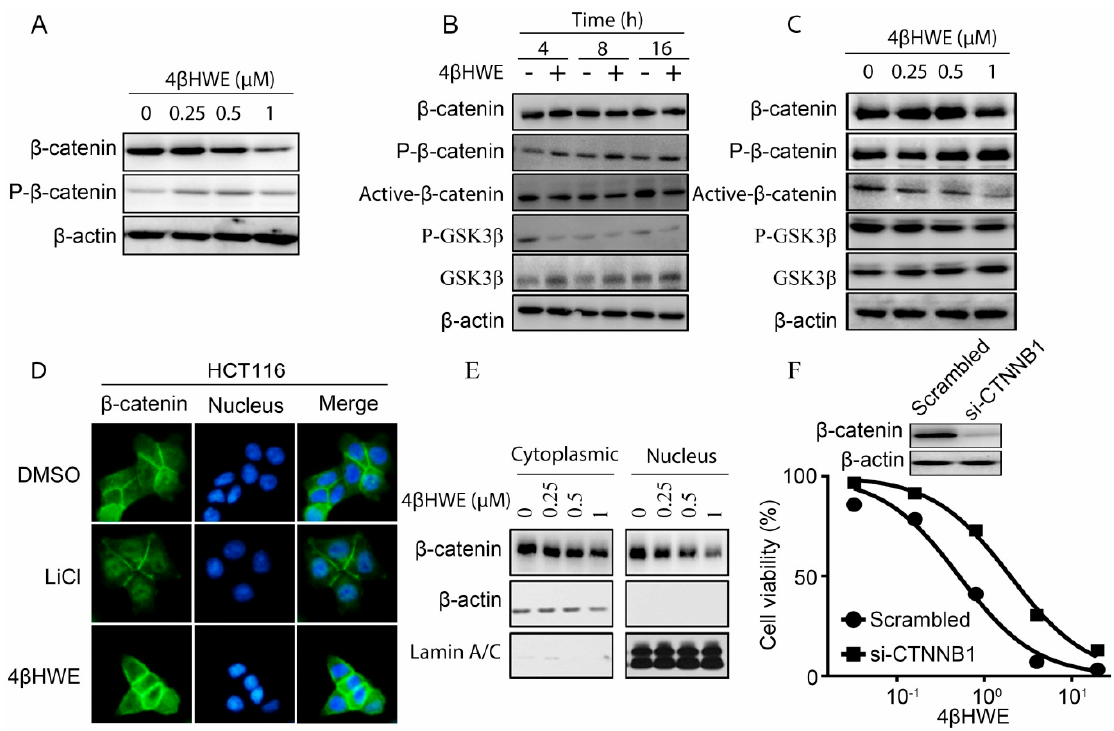
Figure 3. 4 β HWE disrupts the stability and nuclear translocation of β -catenin in colorectal cancer cells. ( A ) HEK293 cells stably transfected with Wnt3a were treated with 4 β HWE for 24 h; β -catenin and p- β -catenin (Ser33, Ser37, and Thr41) were detected with western blot analysis. ( B ) HCT116 cells were treated with 1 μ M of 4 β HWE for 4 h, 8 h, and 16 h or indicated concentrations of 4 β HWE for 16 h respectively ( C ), and western blot analysis of β -catenin, p- β -catenin (Ser33, Ser37, and Thr41), active- β -catenin, p-GSK3 β (Ser9), and total GSK3 β was performed. ( D ) HCT116 cells were incubated with or without 4 β HWE (1 µ M). The β -catenin distribution was detected with the immunofluorescence assay. The green and blue fluorescence represent β -catenin and the nucleus, respectively. ( E ) HCT116 cells were incubated with 0, 0.25, 0.5, and 1 µ M of 4 β HWE for 16 h. The levels of cytoplasmic fraction and nucleic fraction β -catenin in the 4 β HWE-treated HCT116 cell lysates were analyzed by western blot. ( F ) The SW480 cells were transfected with CTNNB1 small interfering RNA for 36 h, and the proliferation inhibitory activity of 4 β HWE was measured with the cell viability assay. The knock-down efficiency was analyzed by western blot.